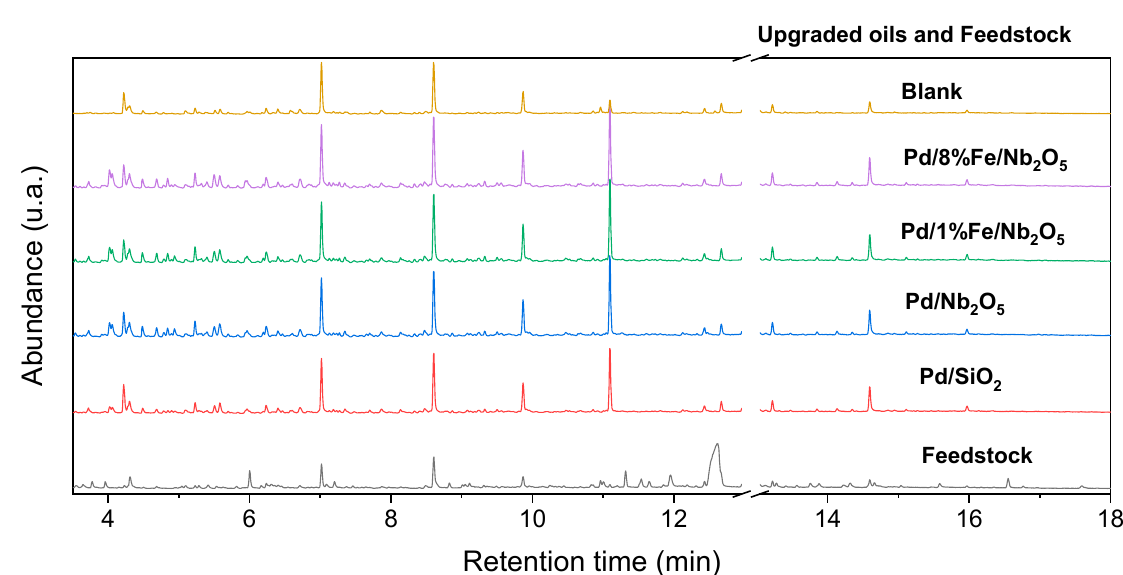
Figure 11. GC-MS: Upgraded oil and feedstock.